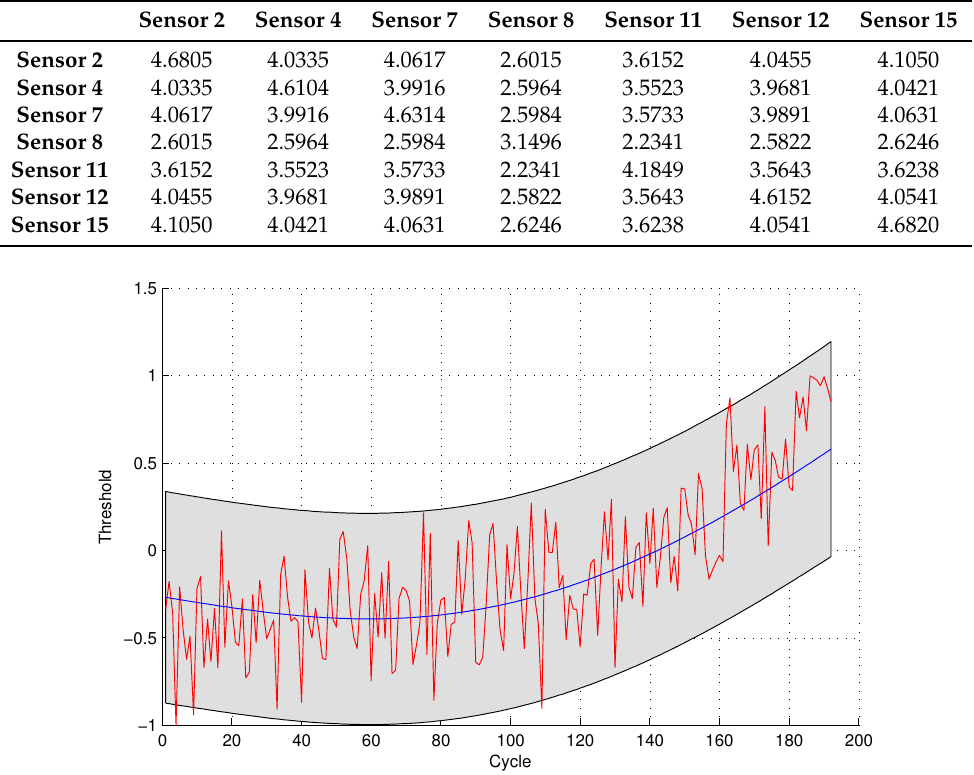
Figure 5. Anomaly detection for sensor data set 1 with Gaussian Process Regression (GPR) for the quantitative sensor selection.